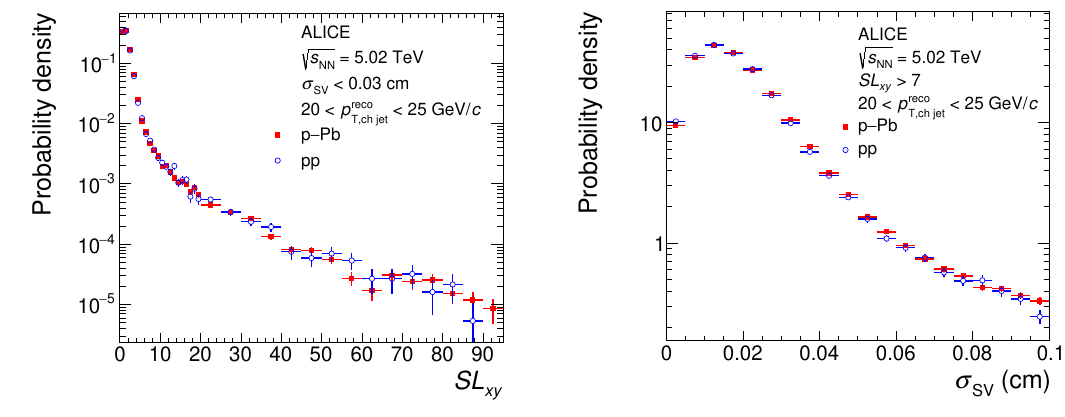
Figure 4. Distributions of the tagging discriminators used in the SV method, SL xy (left) and σ SV (right), for pp and p-Pb